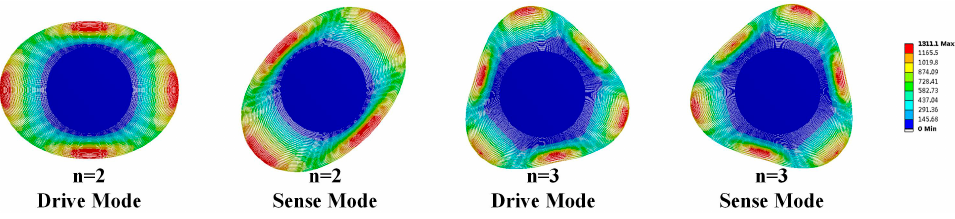
Figure 2. The different modes of DRG.